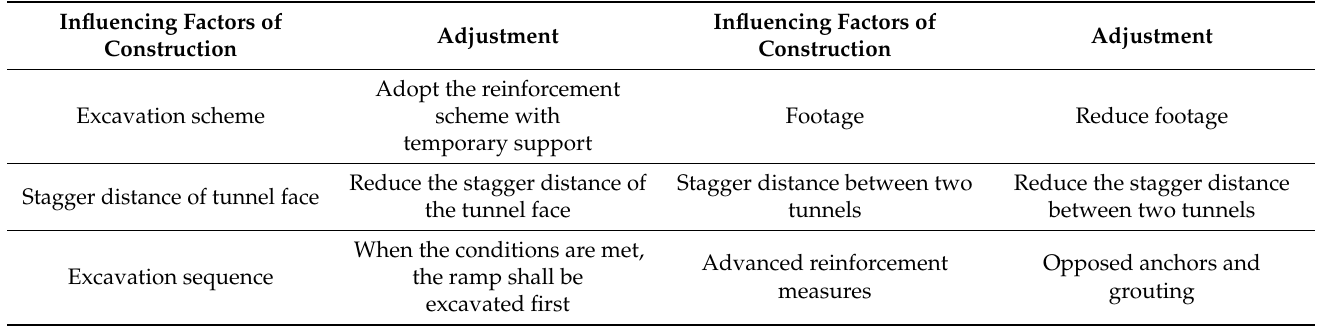
Table 14. Adjustment of various influencing factors of construction due to the downgrading of the middle rock